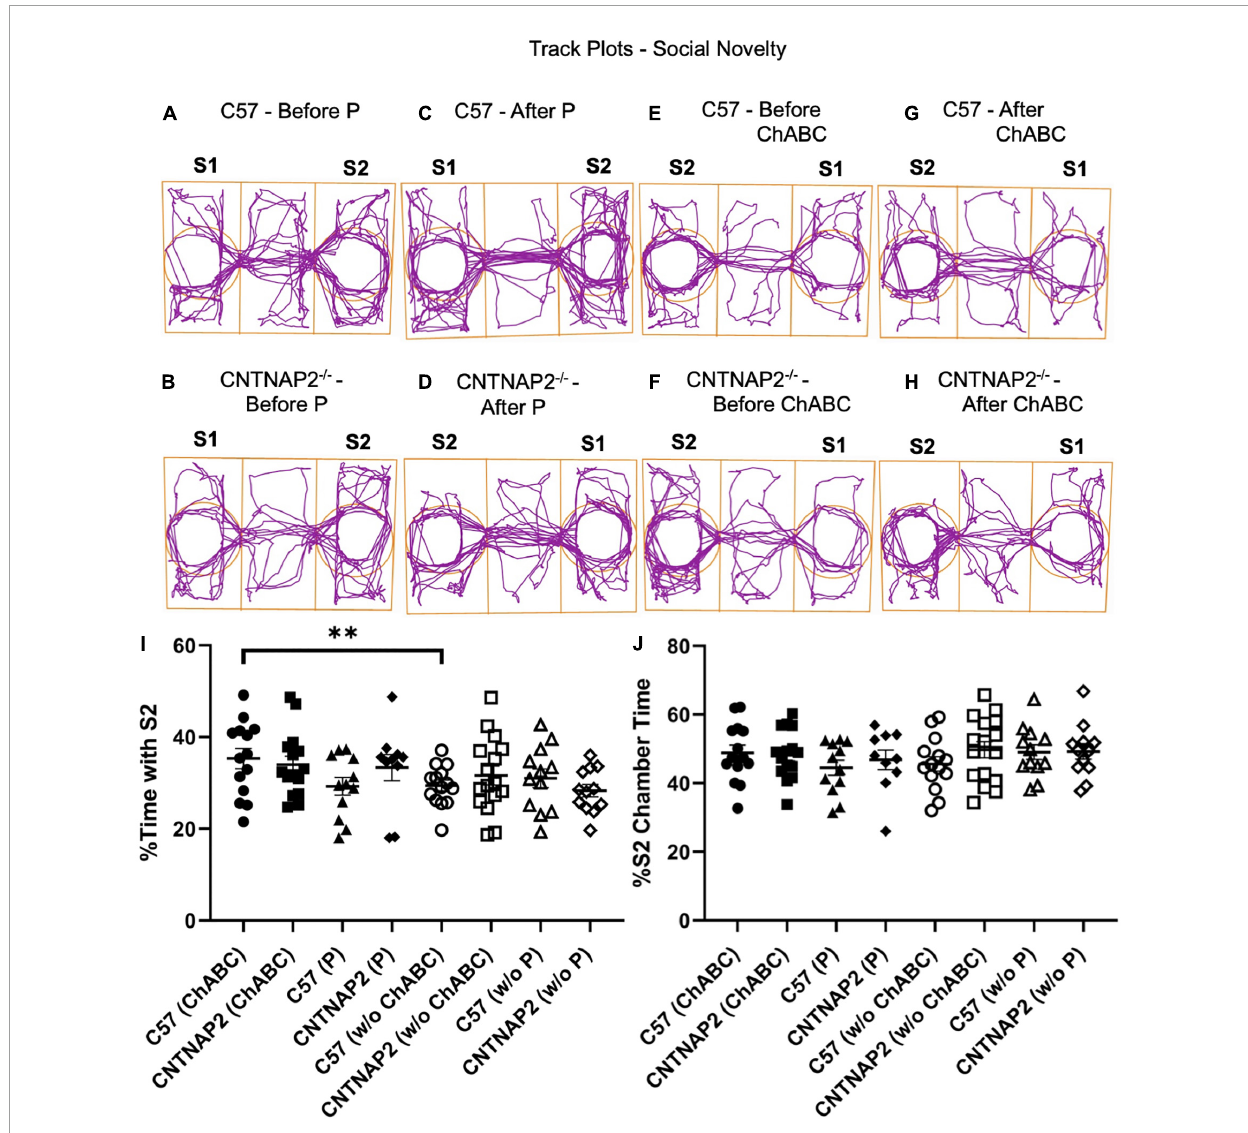
FIGURE5 Assessment of social novelty behaviors in the three-chamber social interaction task. (A–H) Example track plots display the position of the animal’s center point for the total test duration before penicillinase injection (A,B) , after penicillinase injection (C,D) , before chondroitinase ABC injection (E,F) , and after chondroitinase ABC (G,H) injections in C57BL/6J and CNTNAP2 − / − mice. (I,J) Quantification of three-chamber social novelty according to percentage time spent with stranger mice performance (I) and percentage time spent in chamber housing stranger mice (J) for C57BL/6J and CNTNAP2 − / − mice. C57BL/6J mice treated with chondroitinase ( n = 8 males; n = 6 females) and penicillinase ( n = 6 males; n = 6 females). CNTNAP2 − / − mice treated with chondroitinase ( n = 8 males; n = 7 females) and penicillinase ( n = 4 males; n = 6 females). Data